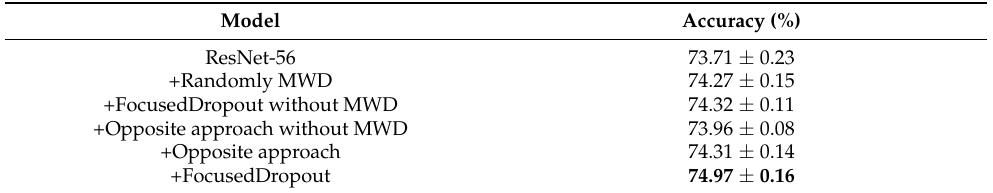
Table 5. Comparisons among baseline, randomly magnifying weight decay, FocusedDropout without magnifying weight decay, opposite approach and FocusedDropout of CIFAR100 on